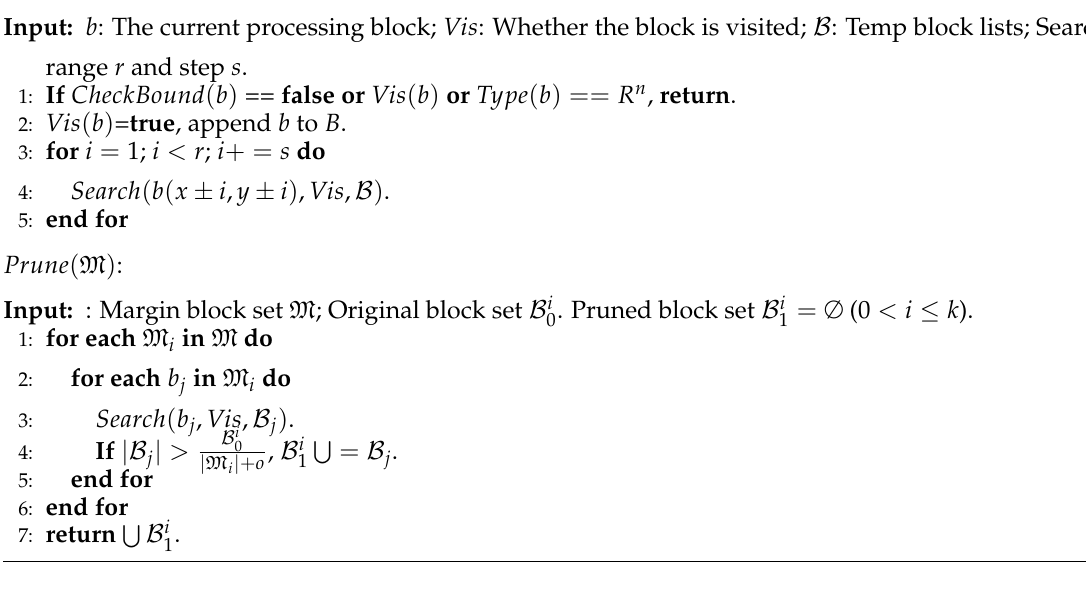
Algorithm 4 Motion Area Pruning